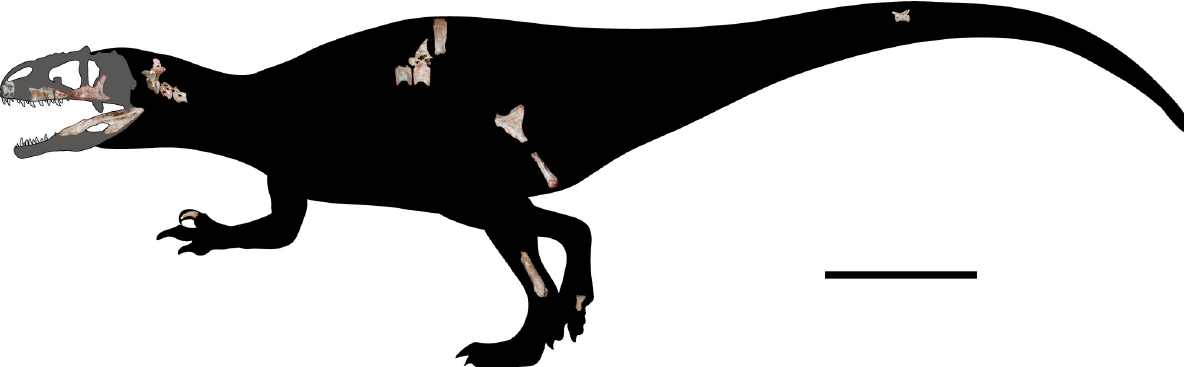
Fig 2. Skeletal reconstruction of Siamraptor suwati . Cranial elements were scaled to fit in with the holotype (surangular). Scale bar equals 1 m.